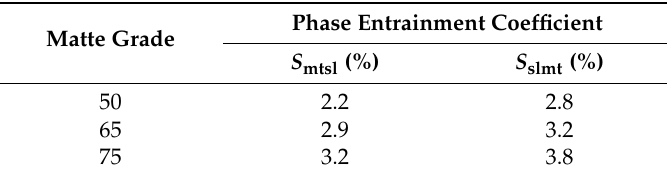
Table 4. Phase entrainment coefficient in the SKS